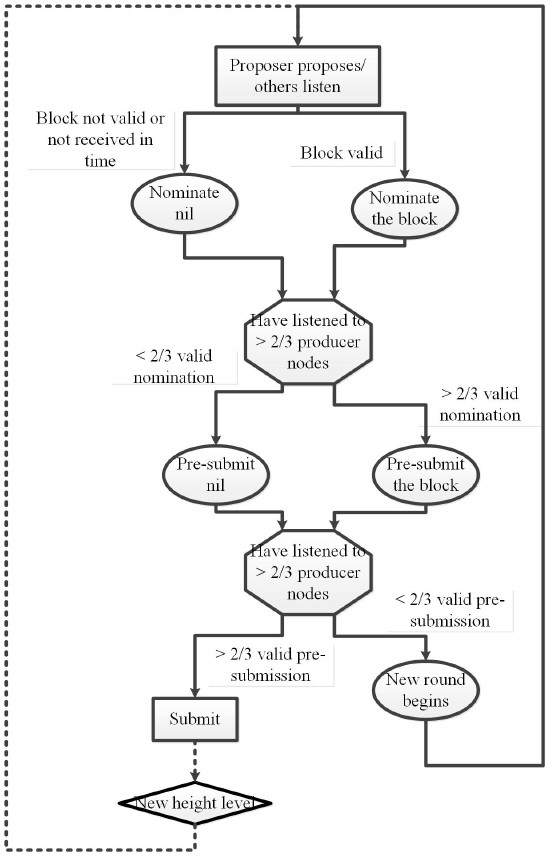
Figure 1. Flow of the designed consensus